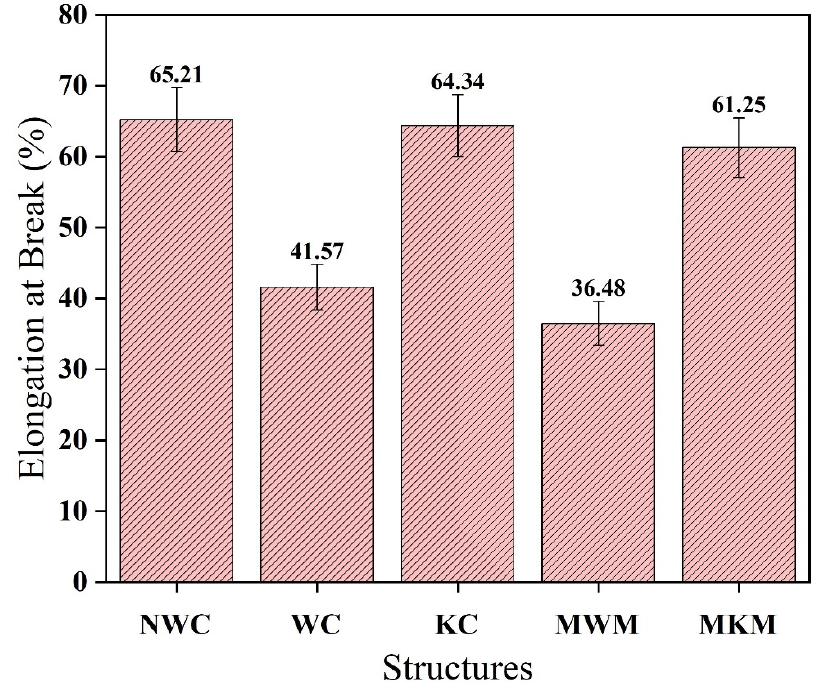
Membranes 2022 , 12 , x FOR PEER REVIEW Figure 14. The comparison of elongation of developed nanofiber/textile composite with reference mesh.